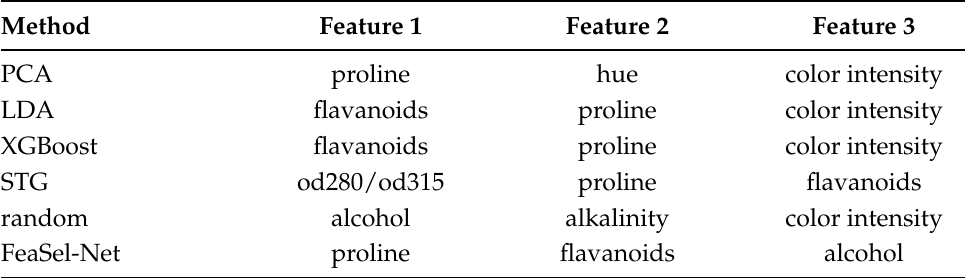
Table 2. Selected features from all analyzed FS methods.